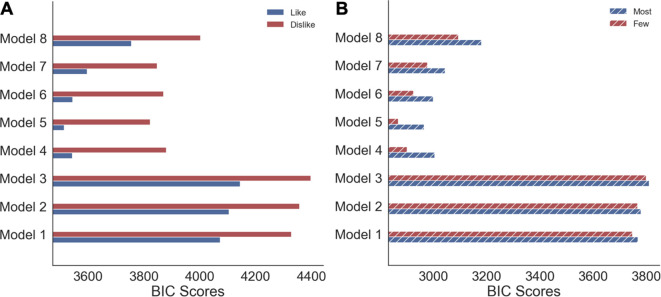
Model comparison of hierarchical logistic regressions for choice.(A) Value and (B) Perceptual Experiments. Solid colour indicates the Value Experiment and striped colours indicate the Perceptual experiment.